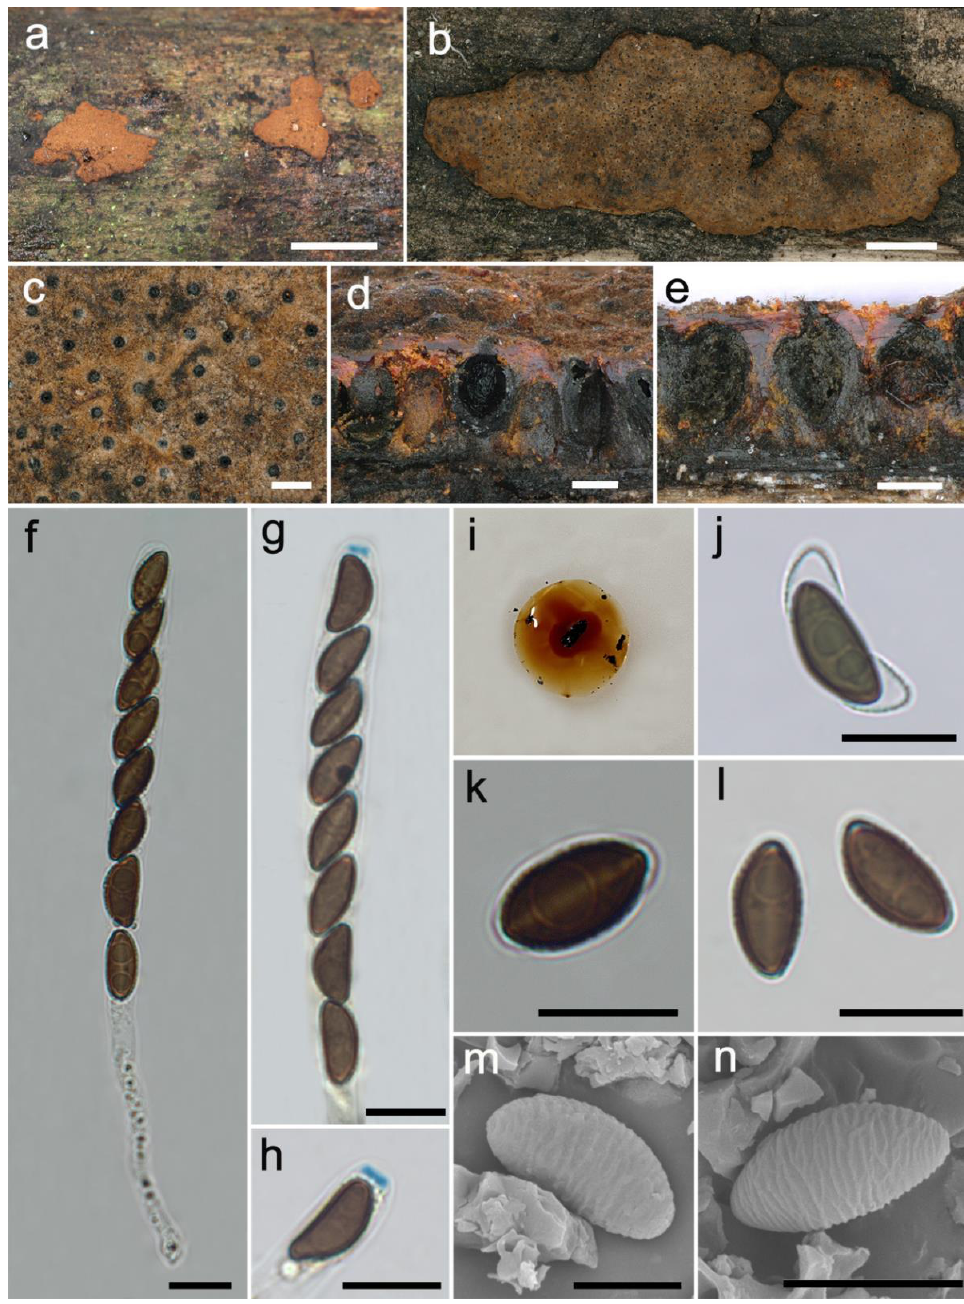
Figure 3. Hypoxylon medogense (holotype FCATAS 4061). ( a , b ) Stromata on the bark of dead wood. ( c ) Stromatal surface. ( d , e ) Stroma in vertical section showing perithecia and ostioles. ( f ) Asci in water. ( g ) Asci in Melzer’s reagent. ( h ) Apical apparatus in Melzer’s reagent. ( i ) KOH-extractable pigments. ( j ) Ascospore in 10% KOH. ( k ) Ascospore in water showing germ slit. ( l ) Ascospores in